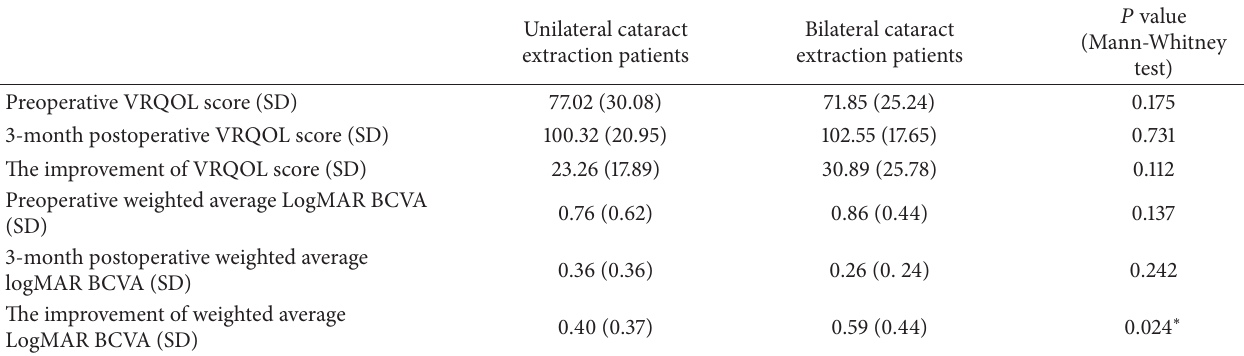
Table 3: Comparison of VRQOL score and weighted average LogMAR BCVA in patients undergoing either unilateral or bilateral cataract extraction, ∗ 𝑃 < 0.05 .